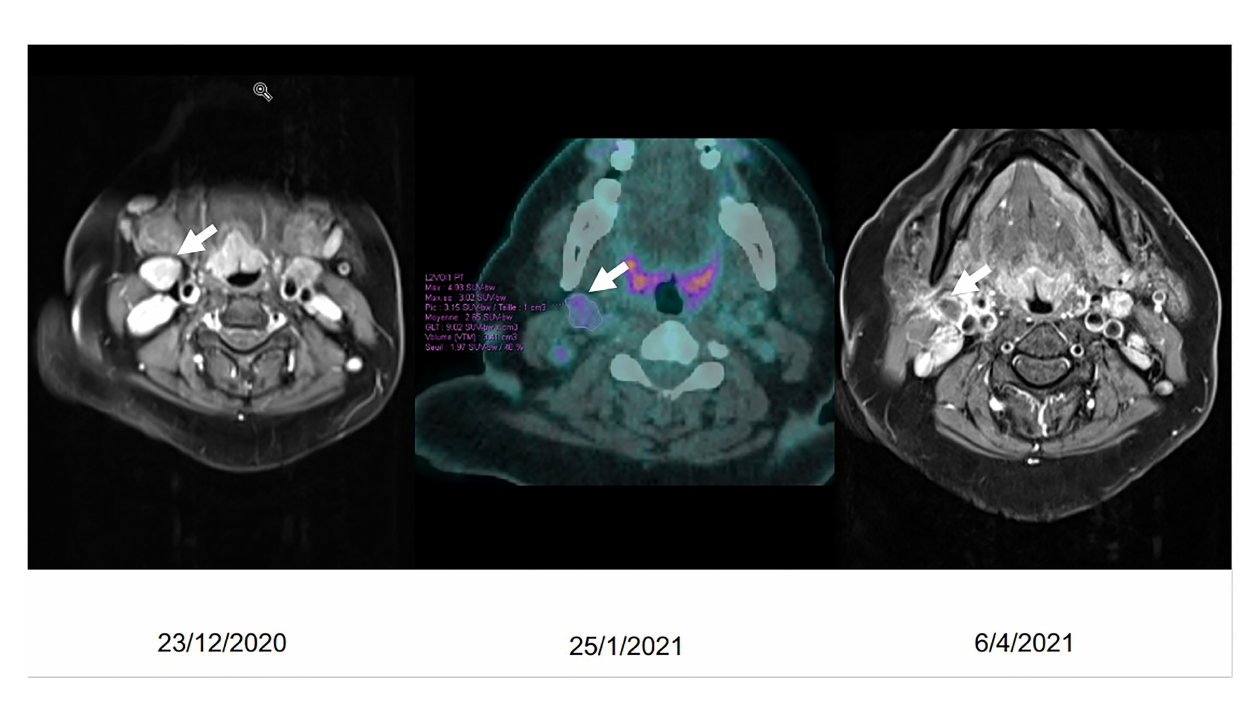
FIGURE 3 | Evolution in time of the laterocervical lymph